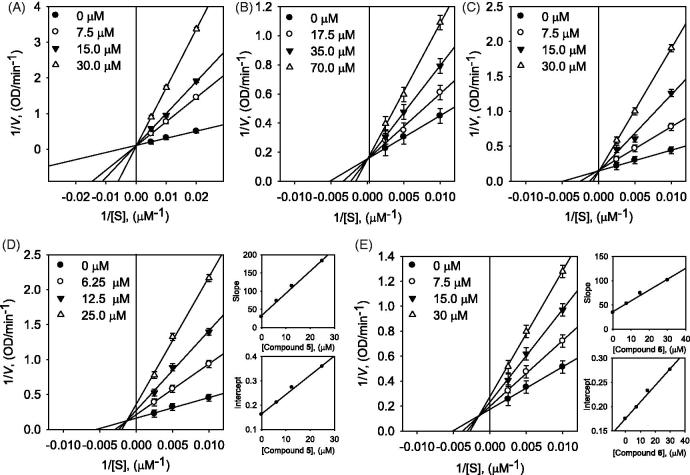
Lineweaver–Burk plots for α-glucosidase (A) compound 2, (B) compound
3, (C) compound 4, (D) compound 5, and (E)
compound 6. Insets represent the secondary plots of the slope and
intercept of the straight lines vs. concentrations of compounds.